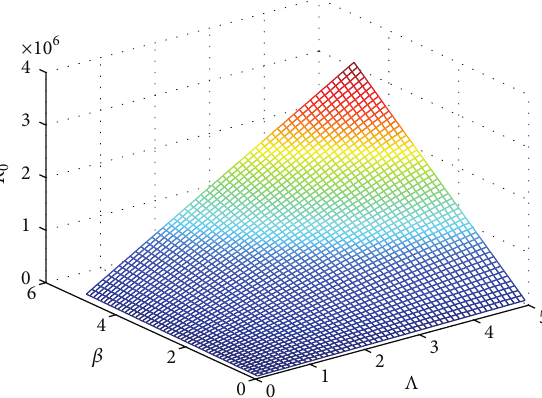
Figure 2: The effect of increasing 𝛽 and Λ on 𝑅 0